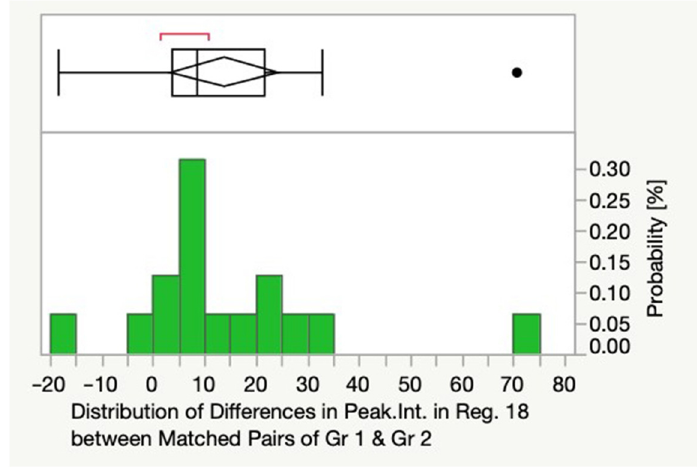
Figure 2. Distribution (boxplot above and histogram below) of differences in peak intensities in Reg. 18 (3.30–3.35 ppm) between matched pairs of Gr 1 and Gr 2. Abbreviations: Gr = group, Peak.Int = peak intensities, ppm = parts per million, Reg. = region. Length of the box = difference between the 25th and 75th percentiles; vertical line in the box = median of the data; whiskers (lines that extend from the box) = expected data variation (they extend 1.5 times the interquartile range from the left and the right side of the box); means diamond: top and bottom of the diamond are a 95% confidence interval for the mean, and the middle of the diamond is the sample average.